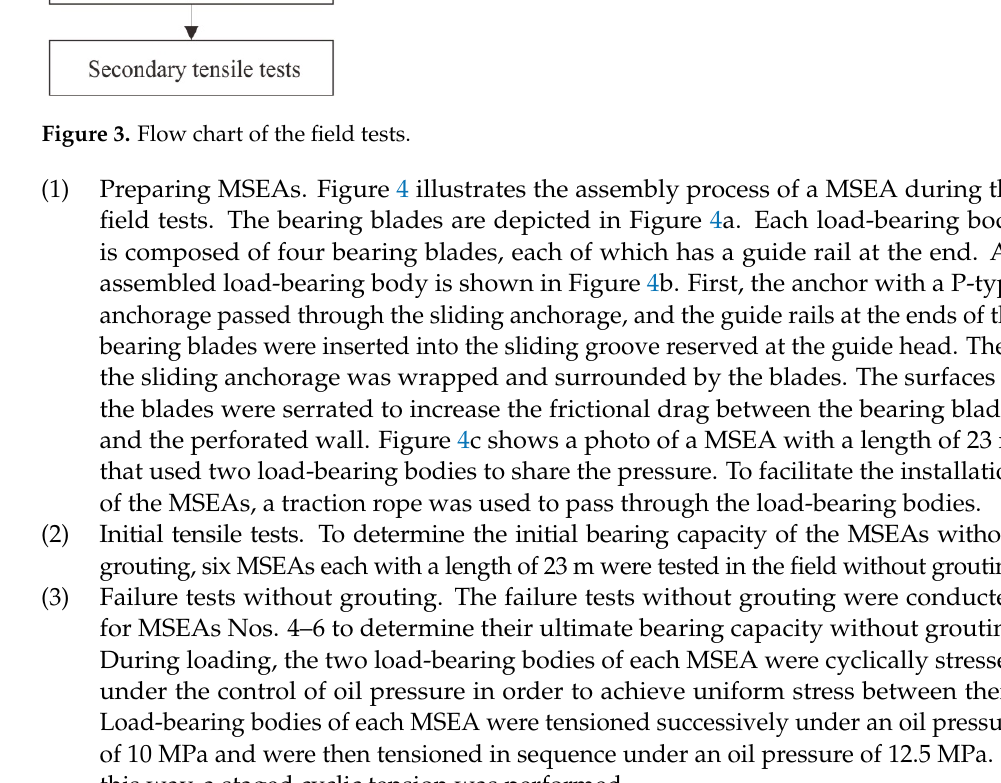
Figure 3. Flow chart of the field tests. (1) Preparing MSEAs. Figure 4 illustrates the assembly process of a MSEA during the field tests. The bearing blades are depicted in Figure 4a. Each load-bearing body is